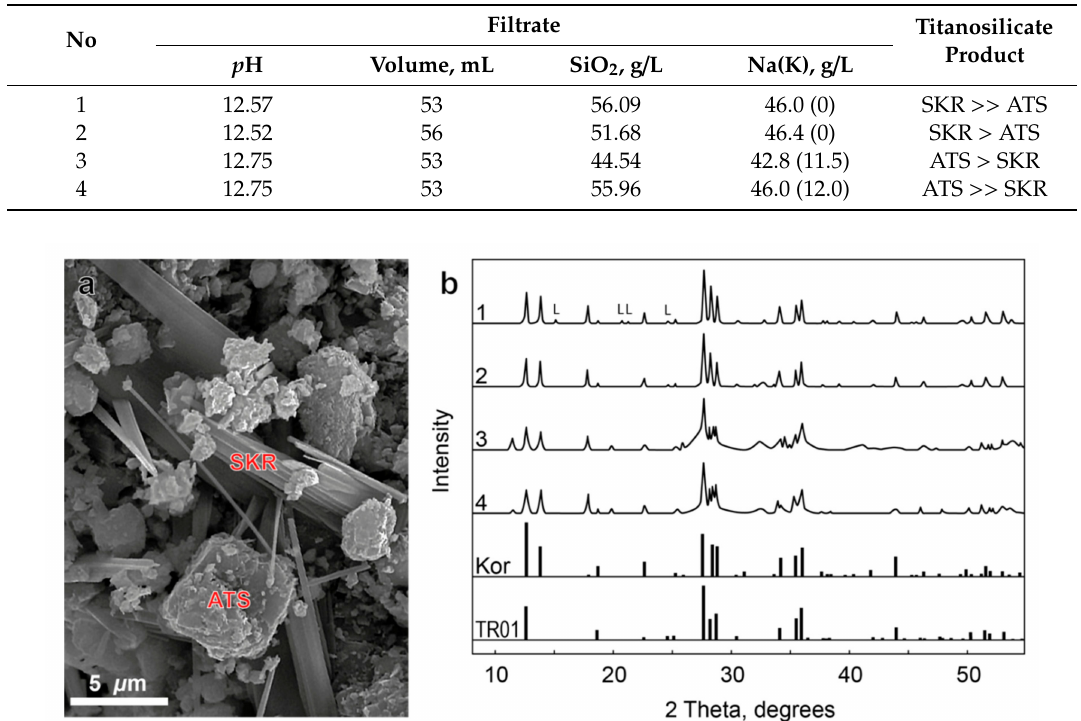
Figure 6. SE image of sample 3 ( a ) and powder X-Ray di ff raction patterns of samples 1–4 in comparison with the patterns of natural korobitsynite and TR01 after [24] ( b ).